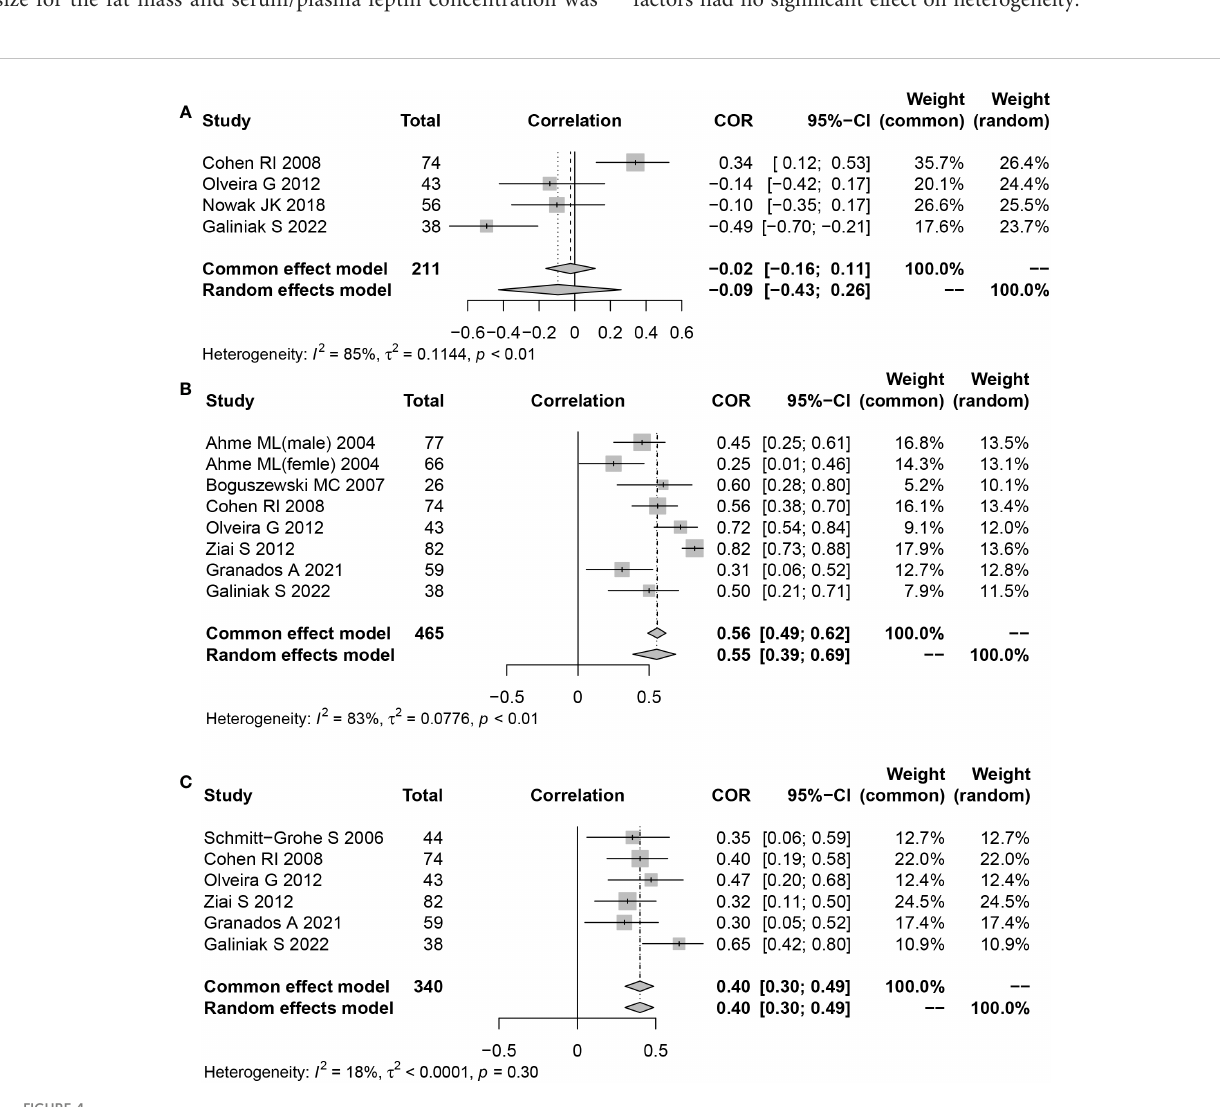
FIGURE 4 Funnel plot of effect sizes measured as correlations between serum/plasma leptin conclusions and FEV1, fat mass and body mass index. (A) FEV1; (B) fat mass; (C) body mass